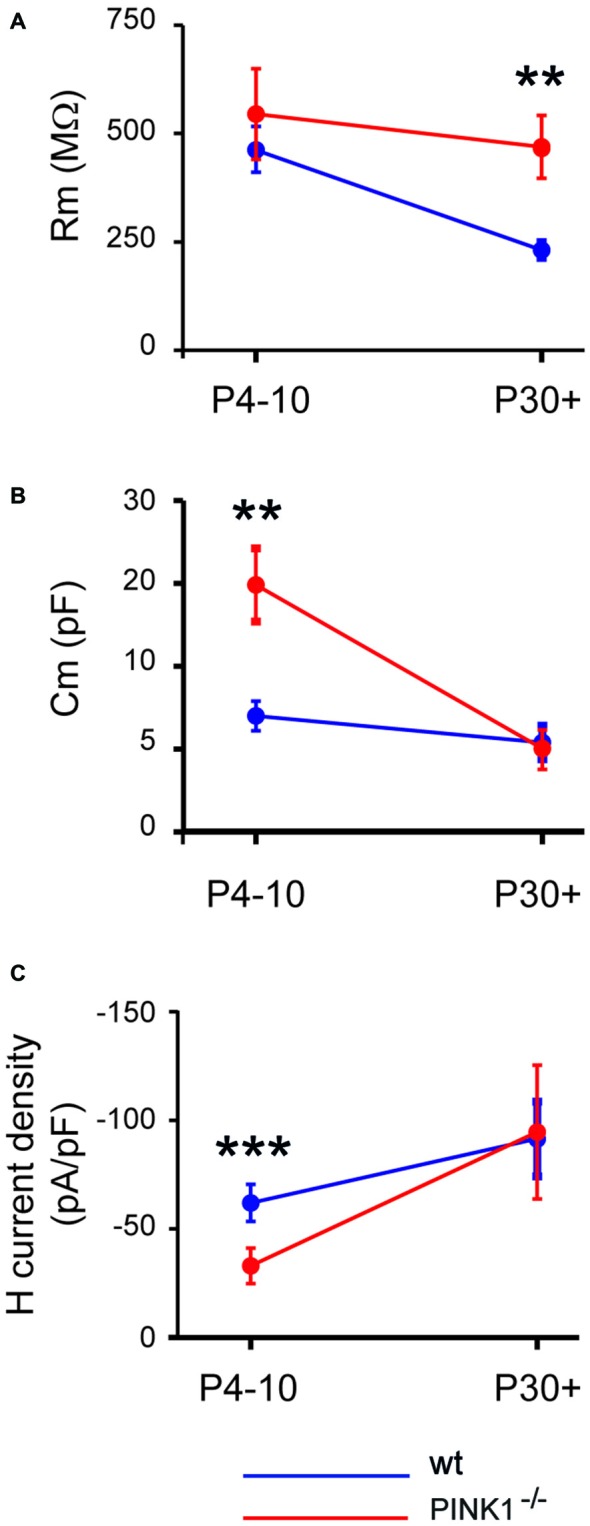
Developmental profile of membrane resistance (A), membrane capacitance (B) and H current density (C) in pink1−/− (red) and wild type (wt; blue) Substantia nigra compacta (SNc) dopaminergic (DA) neurons.